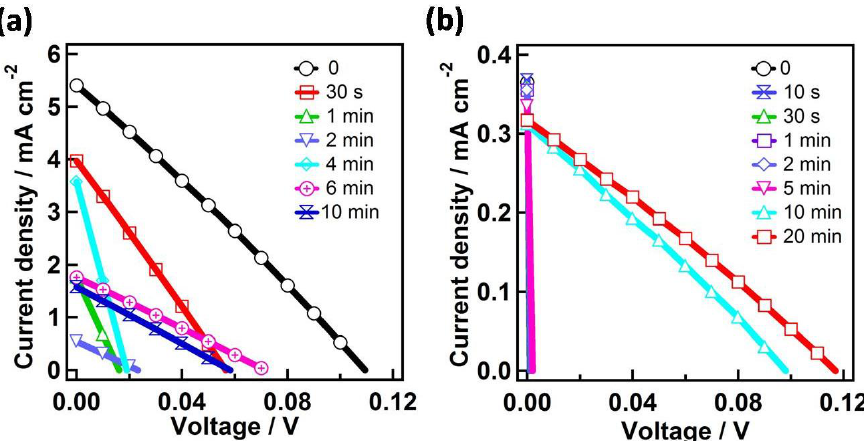
Figure 4. J – V characteristics of printable PSCs of device C ( a ) and device D ( b ) with different electrodeposition times of Mg(OH) 2 .